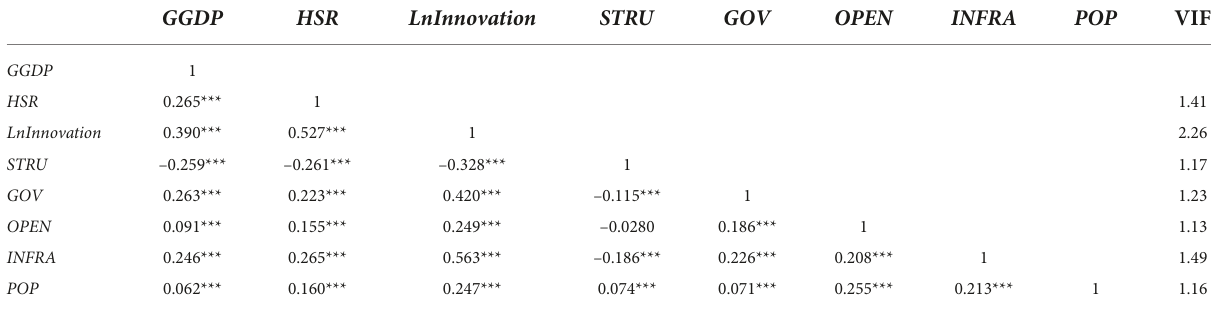
TABLE 3 The results of the correlation matrix.